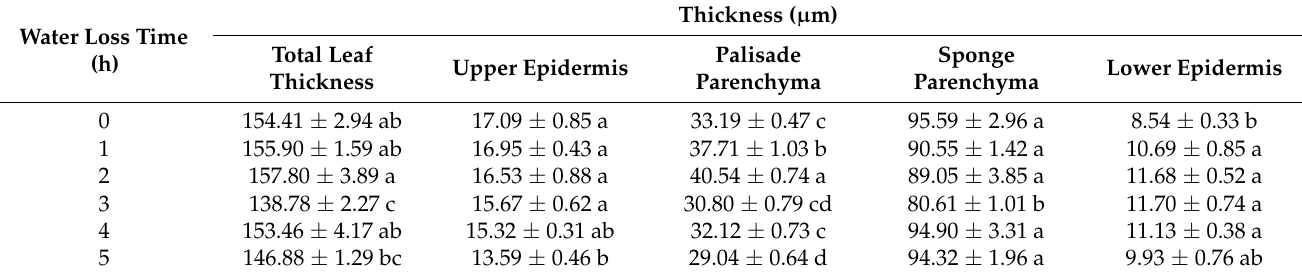
Table 3. Leaf anatomical parameters of B. napus